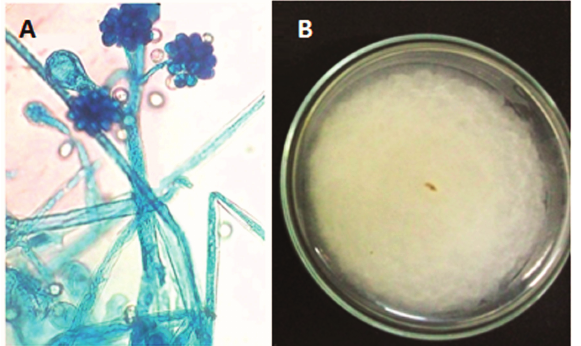
Figure 1. Light microscopic and macroscopic characteristics of Cunninghamella echinulata isolated from Caatinga soil of Northeastern Brazil. Photographes of light microscopy ( A ) and growth on Sabouraud dextrose agar ( B